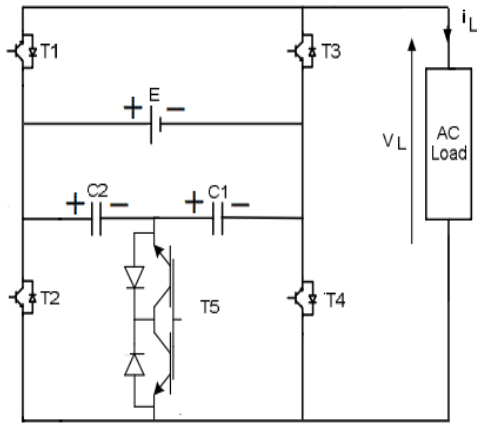
Figure 5. SPUC5 inverter scheme. Table 2. SPUC5 inverter switching